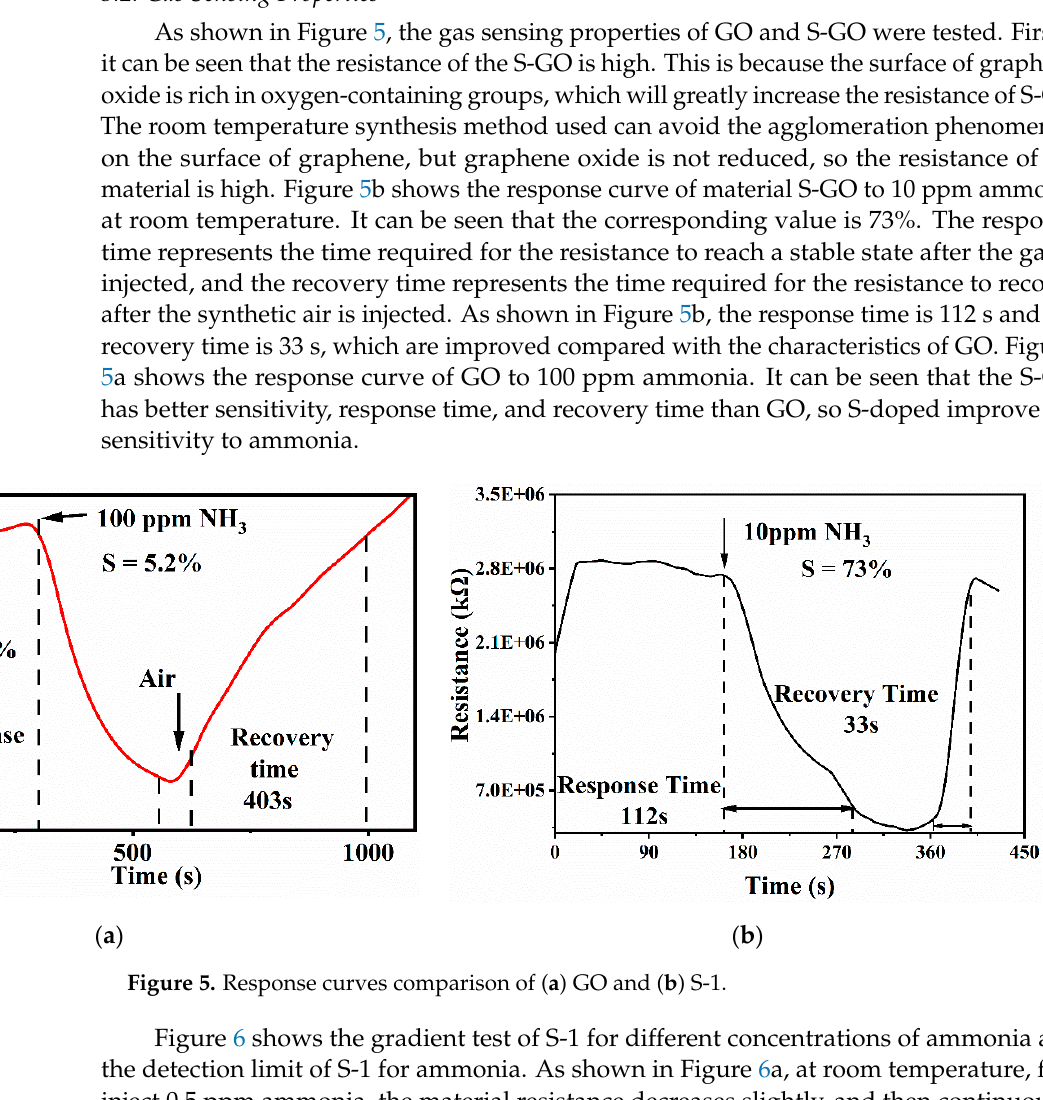
Table 2. Detected signals in the FTIR spectra.